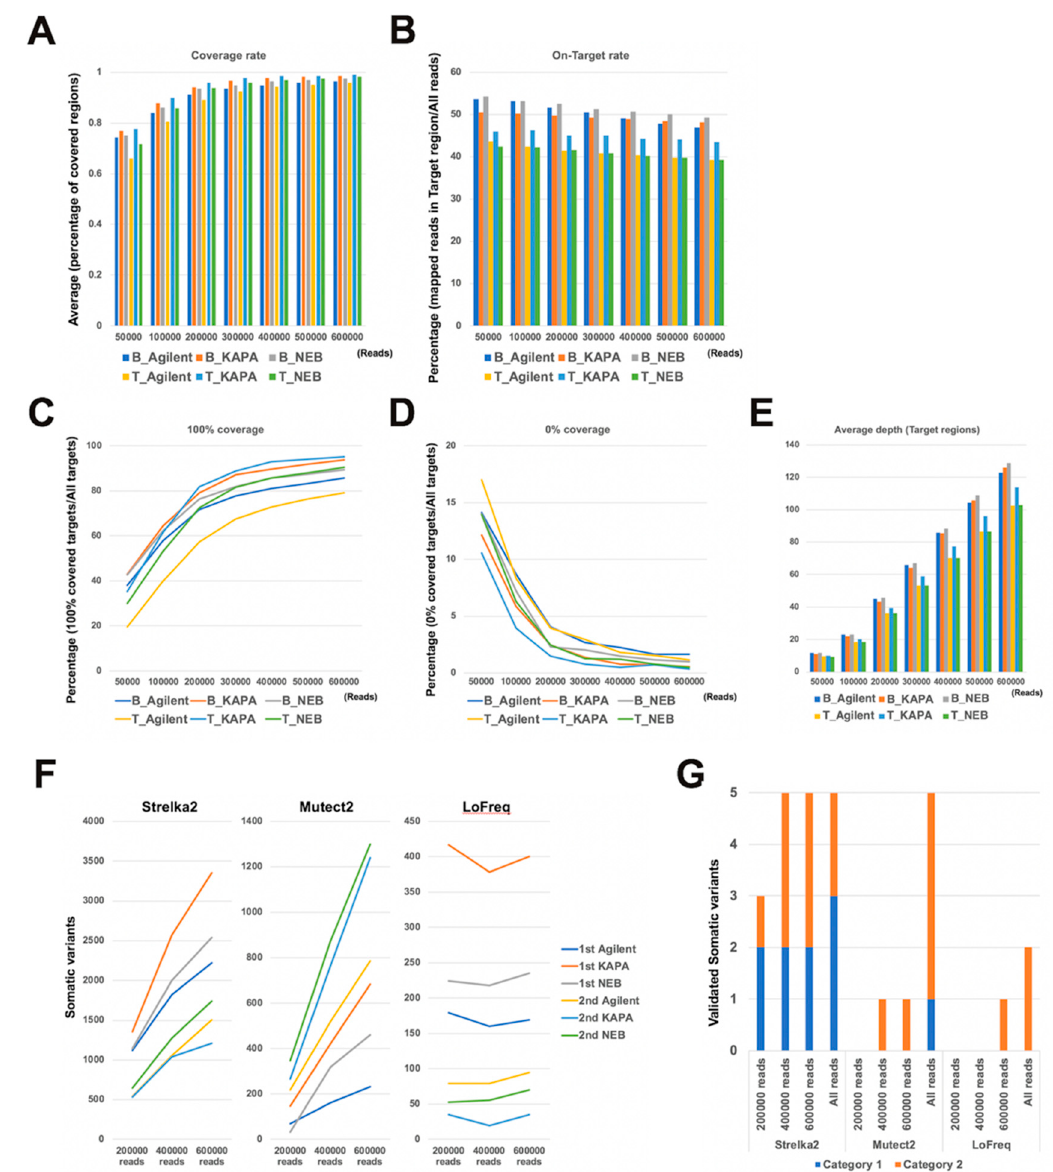
Figure 6. Effect of read number and different DNA polymerases. ( A ) The average coverage rate percentage plotted for each read number. ( B ) The percent of mapped reads on the target region plotted for each read number. ( C ) The percentage of 100% coverage target regions plotted for each read number. ( D ) The percentage of 0% coverage target regions plotted by each read number. ( E ) The average depth plotted for each read number. ( F ) The number of variants detected by somatic variant callers plotted for each read number. ( G ) The number of accurate mutations detected by each somatic variant caller plotted for each read number. B: Blood sample T: Tumor sample.